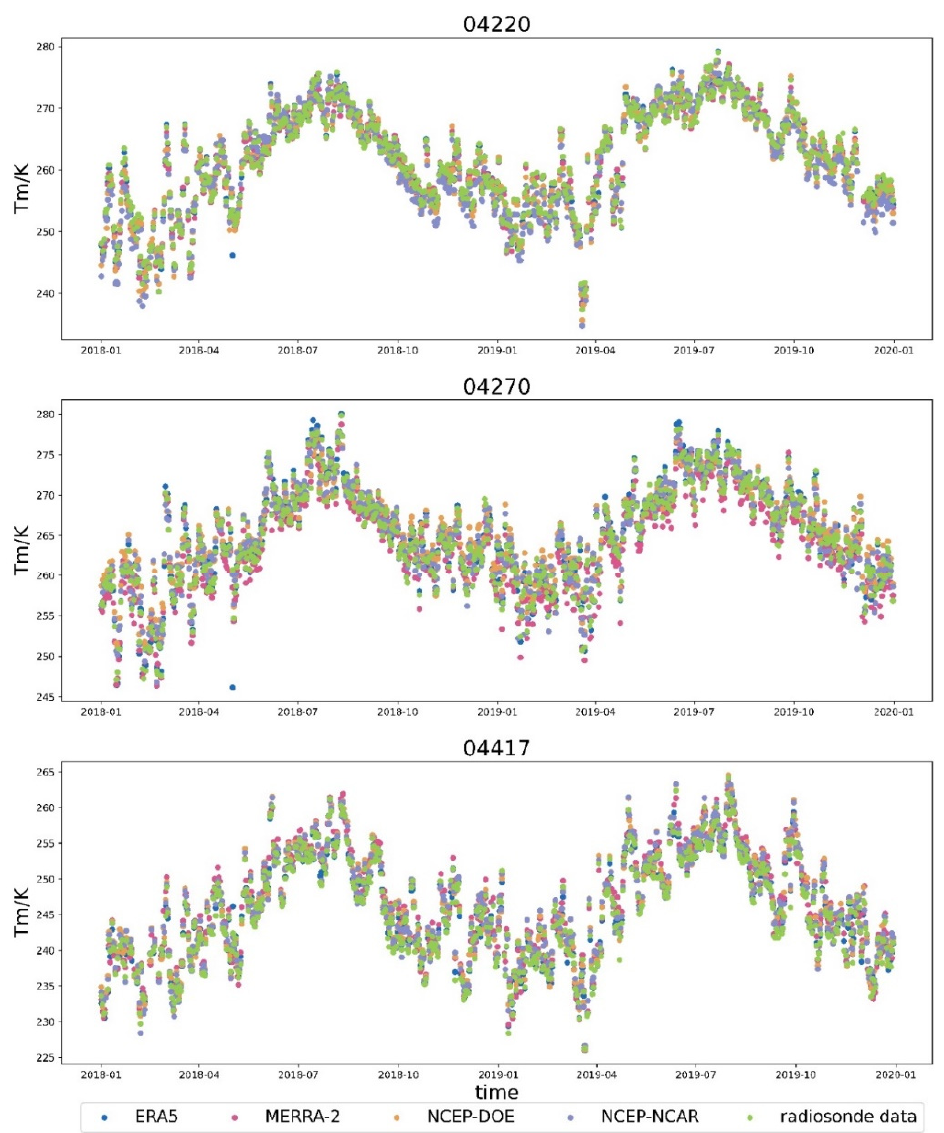
Figure 5. Time series plot for T (cid:2923) in stations 04220, 04270, and 04417, from 2018 to 2019.